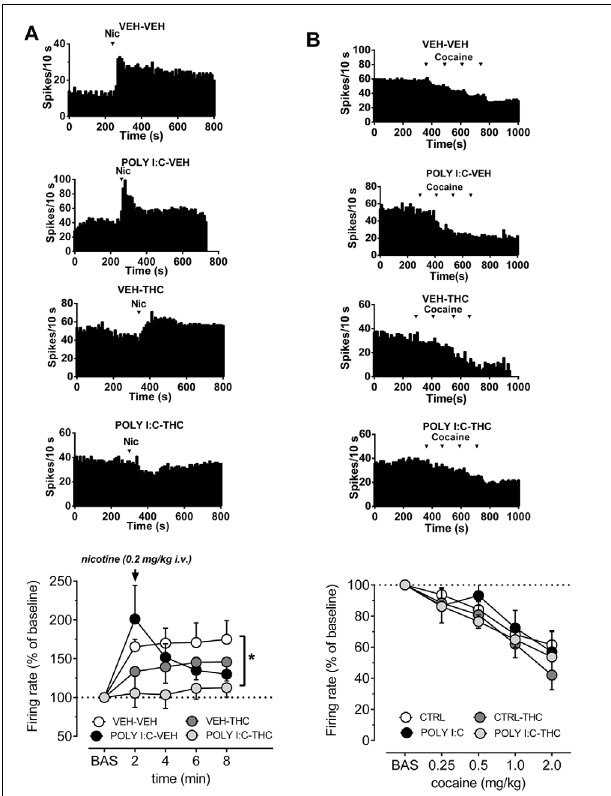
FIGURE 2 | Effects of nicotine and cocaine on firing rate of VTA dopamine neurons in prenatal Poly I:C and adolescent THC treated offspring and their controls. (A) Representative firing rate histograms of VTA dopamine neurons recorded from vehicle-vehicle, Poly I:C-vehicle, vehicle-THC and Poly I:C-THC rats showing the effects of a bolus dose of nicotine (0.2 mg/kg, i.v.). Arrows indicate the times of nicotine injection. The graph shows that the combination of prenatal Poly I:C and adolescent THC prevented nicotine-induced increase of firing rate (vehicle-vehicle, n = 8; Poly I:C-vehicle, n = 6; vehicle-THC, n = 6 and Poly I:C-THC, n = 6; two-way ANOVA and Sidak’s test, ∗ P < 0.05). (B) Representative firing rate histograms of VTA dopamine neurons recorded from vehicle-vehicle, Poly I:C-vehicle, vehicle-THC and Poly I:C-THC rats showing the effects of cumulative doses of cocaine (0.25–2.0 mg/kg, i.v.). Arrows indicate the times of cocaine injections (0.25, 0.25, 0.5, 1.0 mg/kg). The bottom graph displays the dose–response curves of the effect of cumulative doses of cocaine on the firing rate of VTA DA neurons recorded from vehicle-vehicle ( n = 5), Poly I:C-vehicle ( n = 6), vehicle THC ( n = 4) and Poly I:C-THC ( n = 4). Results are presented as mean ± SEM of firing rate expressed as a percentage of baseline levels.